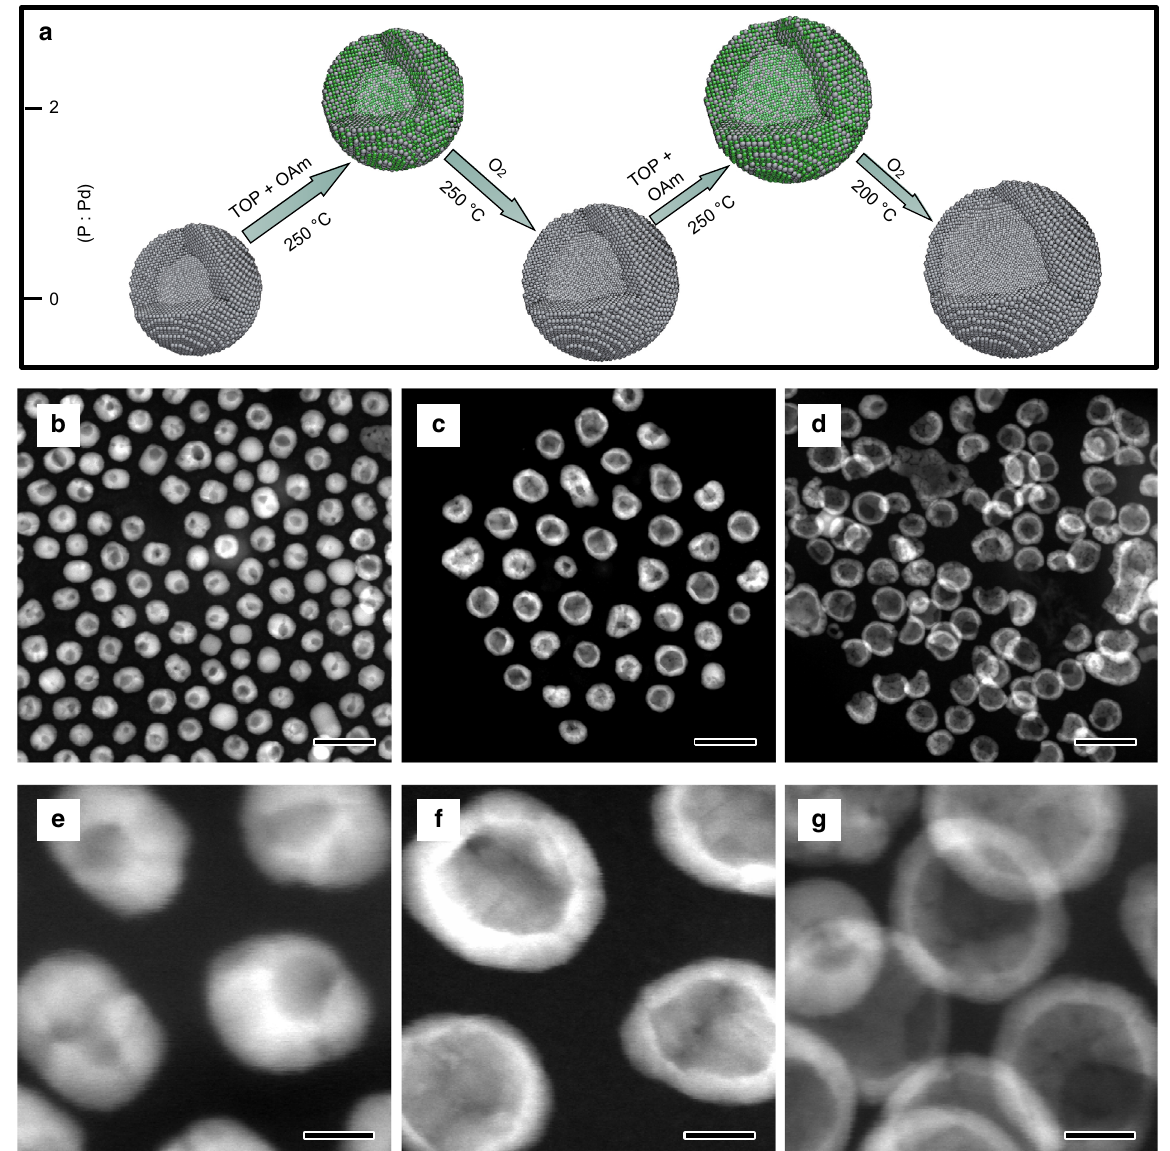
Fig. 4 Synthesis of hollow Pd nanocrystals with thin walls by repeating the Kirkendall cavitation process three times. a Schematic illustration showing the evolution of the molar ratio of P:Pd during repeated cavitation cycles. b – g HAADF-STEM images, high-resolution HAADF-STEM images of the obtained hollow nanocrystals after repeated cavitation cycles: b , e H-Pd-1 obtained by one cavitation cycle; c , f H-Pd-2 achieved by two cavitation cycles; and d , g H-Pd-3 produced by three cavitation cycles. Scale bars in b – d are 50 nm. Scale bars in e – g are 5 hollow Pd nanocrystals obtained after the fi rst cycle (H-Pd-1, Fig. 4b, e, with an outer diameter of ~20.7 nm and pore size of ~7.5 nm). As expected, the polycrystalline hollow Pd nanocrystals were converted to amorphous hollow PdP 2 nanoshells after reacting with TOP (Supplementary Fig. 12), con fi rming the insertion of P to H-Pd-1 through the phosphorization reaction. It (~19.2 nm), as demonstrated in Fig. 4d, g, and Supplementary is important to note that the phosphorization reaction main- Fig. 13. The shells of the hollow nanocrystals became as thin as tained the hollow shell morphology, implying that it was not a 2 – 3 nm. Clearly, the shell thickness decreased as the diameter of simple reverse process of the prior dephosphorization reaction. hollow Pd nanocrystals increased, since no additional Pd source was introduced into the reaction system (Fig. 5). We further calculated the volume of the initial nanocubes and the obtained thin shells. Initially, the volume of a single nanocube is around 5800 nm 3 . The volumes of Pd shells was calculated to be 4500 nm 3 for H-Pd-1, 5700 nm 3 for H-Pd-2, and 5800 nm 3 for H-Pd-3. These results indicated that Pd nanocubes were